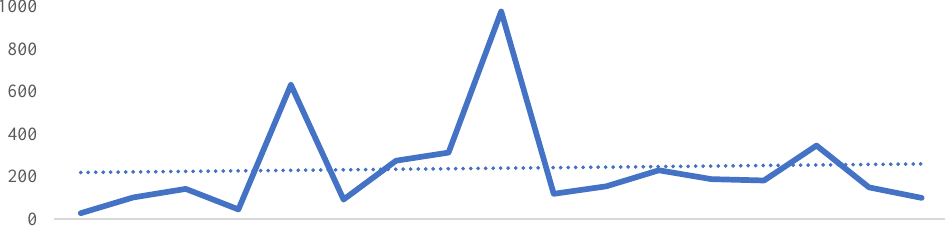
Figure 3. Rates of confirmed human cases of Q fever in four European Countries from 2010 to 2019 [148–150].